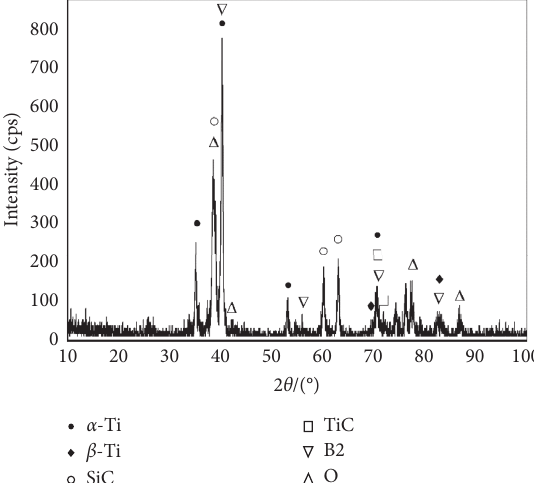
Figure 4: XRD spectrum of the